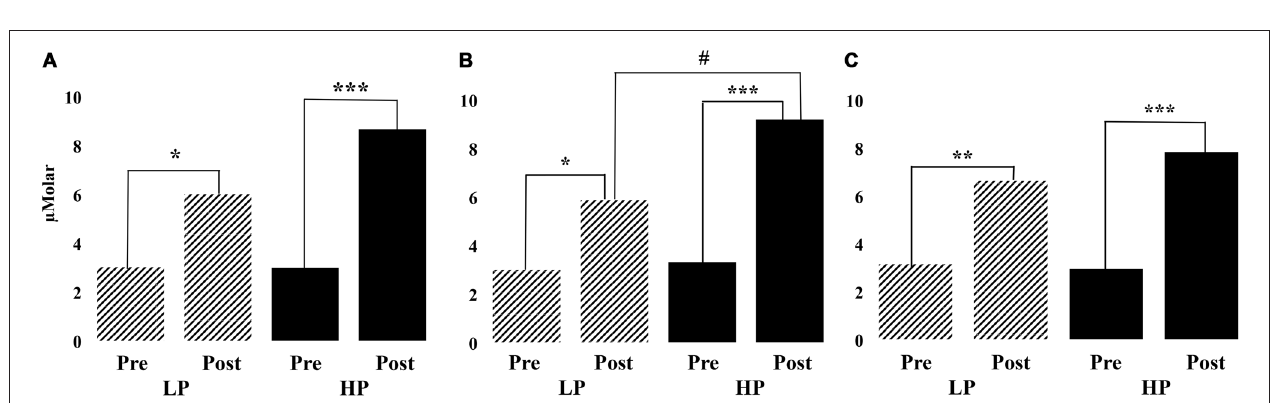
FIGURE 5 | The oxygenation values for pre- and post-exercise 2-Back sessions in left (A), center (B) and right (C) areas of PFC in high and low performance groups. Within group significances are marked with “ ∗ ” (where “ ∗ ” denotes p < 0.05, “ ∗∗ ” denotes p < 0.01, and “ ∗∗∗ ” denotes p < 0.001); between group significances are marked with “ # ” (where “ # ” denotes p <